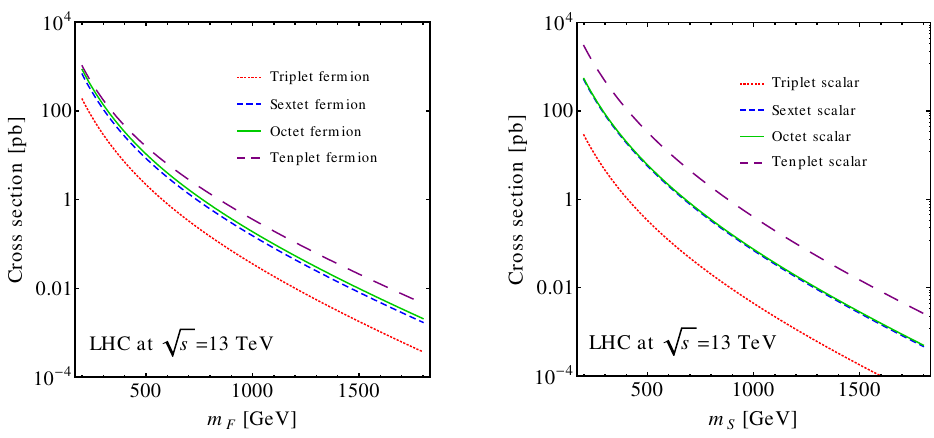
√ s = 13 TeV for the pair production of representations: triplet (dotted C